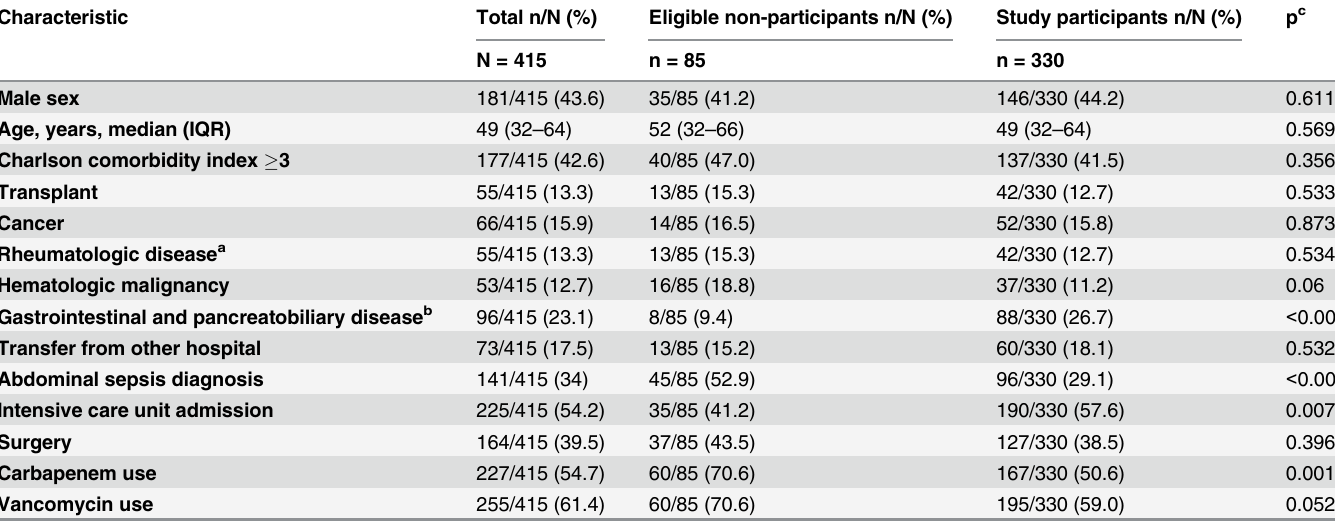
Table 1. Analysis of clinical and demographical differences among participants and